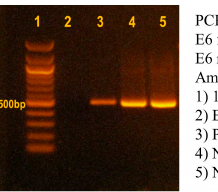
Figure 5. Comparison of PCR assay between E6-HPV16 DNA isolated from synthetic plasmid and E6-HPV16 DNA isolated using commercial M-280 MPs, which they were used to make a PCR with set of E6 primers. The DNA nanoconstructs with commercial MPs particles showed 2.6-fold higher fluorescence of Ethidium bromide (EtBr) stained E6-HPV16 bands than the positive control using synthetic plasmid E6-HPV16-pUC57. Conditions for gel electrophoresis were as follows: 1% agarose gel, 1% TAE buffer.